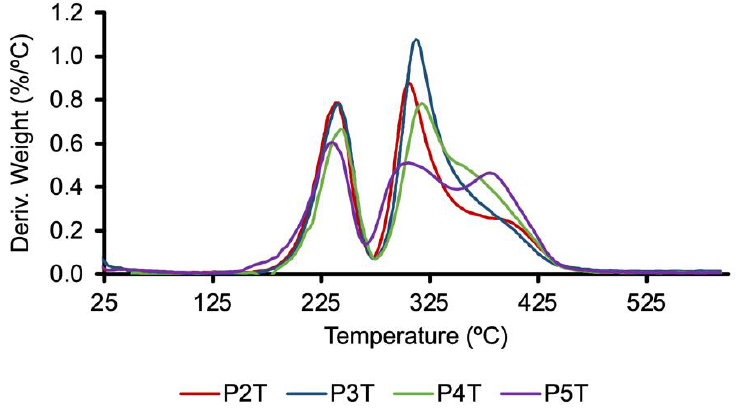
Figure 6. Derivative of TGA curves for polytriazoles: P2T, P3T, P4T, and P5T, measured at 10 °C/min.